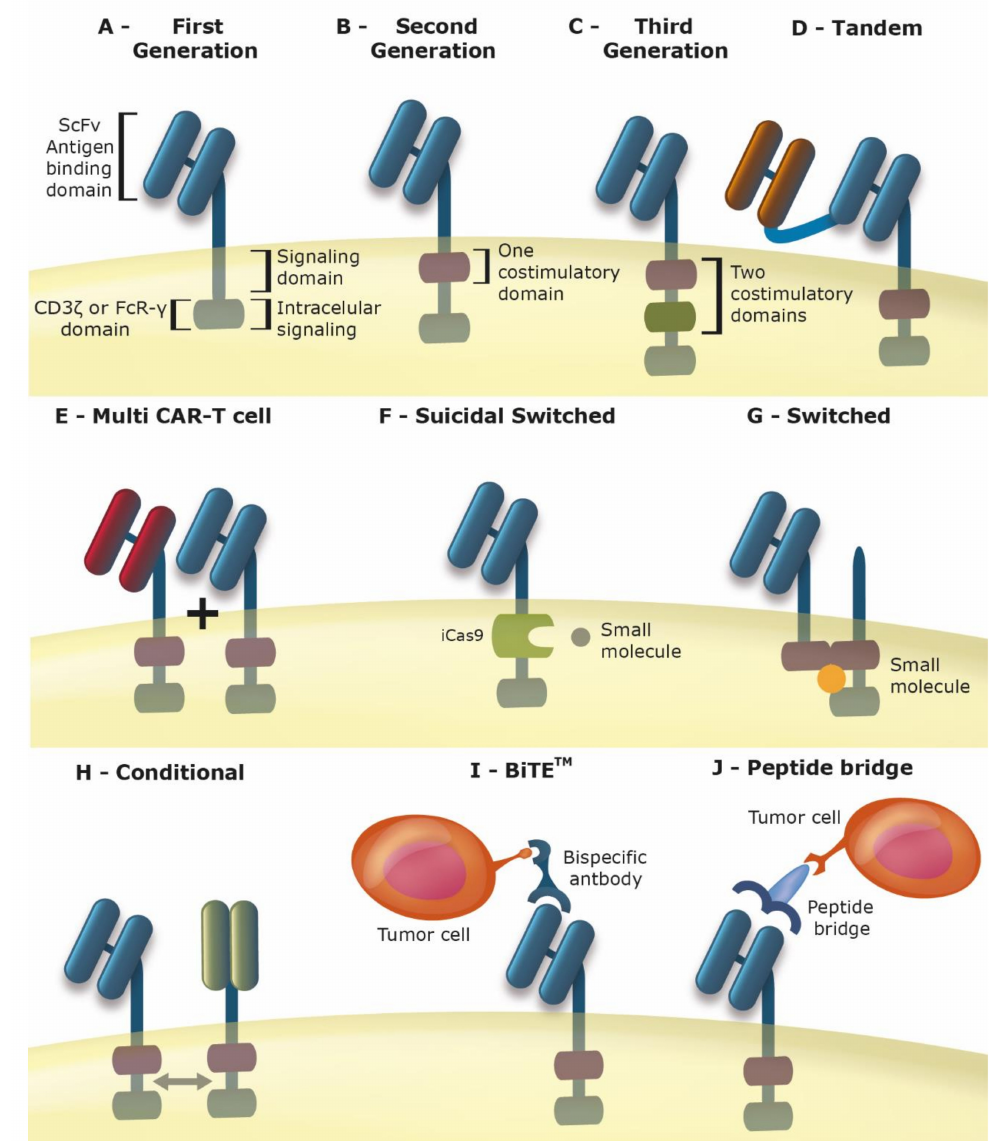
Figure 1. Improving the CAR (chimeric antigen receptors): Schematic representation of alternative CAR designs. ( A ) First Generation CAR-T: extracellular ScFv (single chain fragment variable) domain, transmembrane domain, intracellular signaling domain and CD ÿ or FCR- γ . ( B ) Second Generation CAR-T:extracellularScFvdomain, transmembranedomain, oneintracellularco-stimulatorydomainand CD3 ÿ orFCR- γ (FCreceptor- γ ). ( C )ThirdGenerationCAR-T:extracellularScFvdomain, transmembrane domain, two intracellular co-stimulatory domains and CD3 ÿ or FCR- γ . ( D ) Tandem CAR-T–two ScFv domains in tandem connected by a flexible motif or aminoacid sequence. ( E ) Multi CAR-T cell–The same T-cell presents multiple ScFv CARs in the membrane. ( F ) Suicidal Switched CAR-T–Intracellular domain iCasp9 which can be activated by the administration of a small molecule leading to CAR-T cell death. ( G ) Switched CAR-T–The cell has one CAR with a ScFv that transmits the activation signal upon interaction with a small molecule and a second untargeted CAR. ( H ) Conditional CAR-T–Two CAR-Ts that interact between each other and are only activated when both are connected to their antigens. ( I ) BiTE TM (bispecific t cell engager) CAR-T–CAR-T that only ligates to tumoral antigen when a bispecific (CAR-tumor) antibody is administered. ( J ) Peptide bridges CAR-T–Universal CAR-T that will be activated when a peptide bridge links the CAR-T ScFv domain to a cellular antigen, thus the peptide bridge interacts with the ScFV domain as well as the cellular